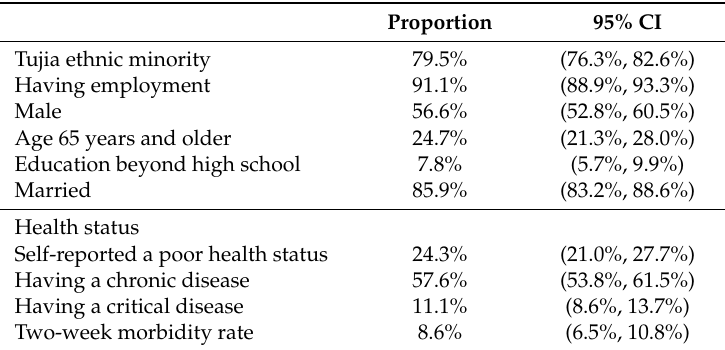
Table 1. Main characteristics of the participants. Table 1. Main c haracteristics of the participants.